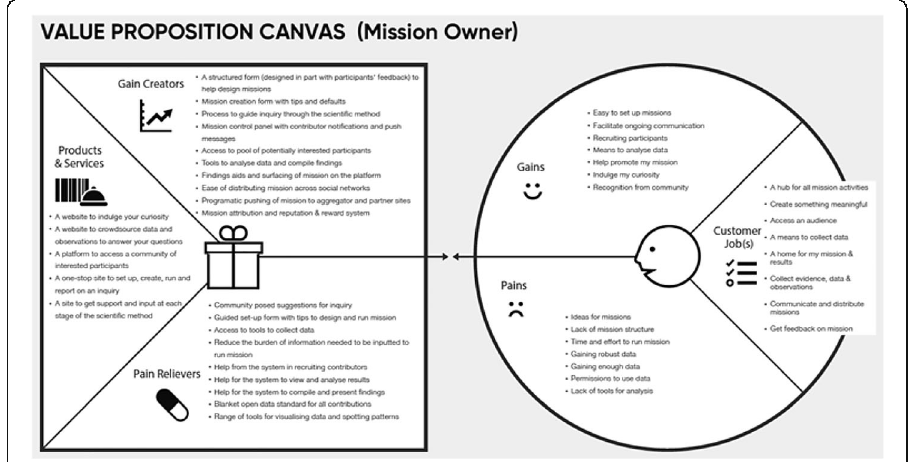
Fig. 6 Interview themes from the perspective of a mission